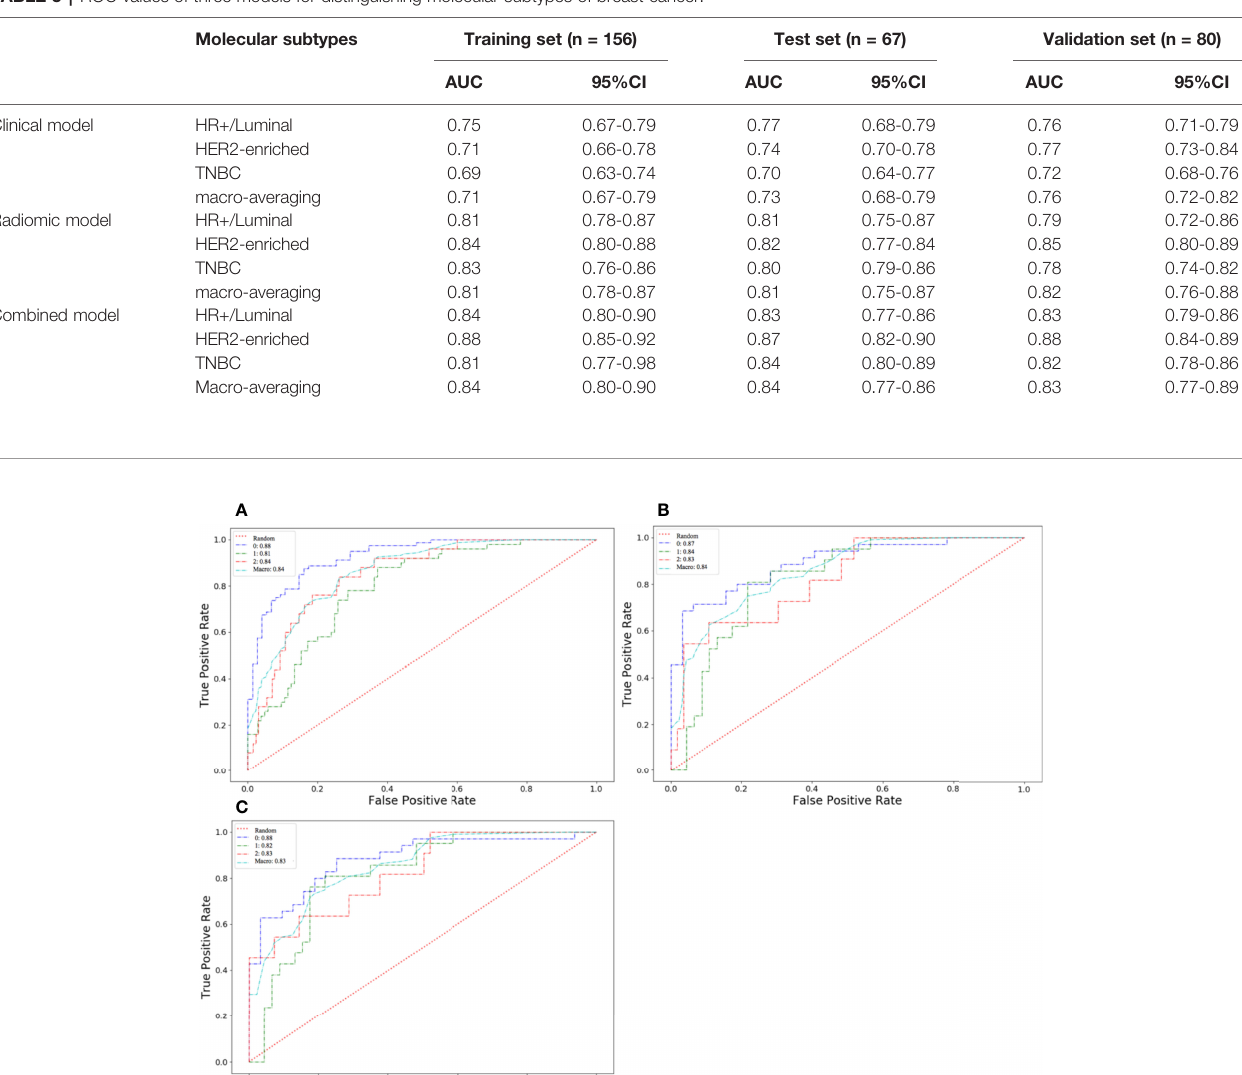
TABLE 3 | ROC values of three models for distinguishing molecular subtypes of breast